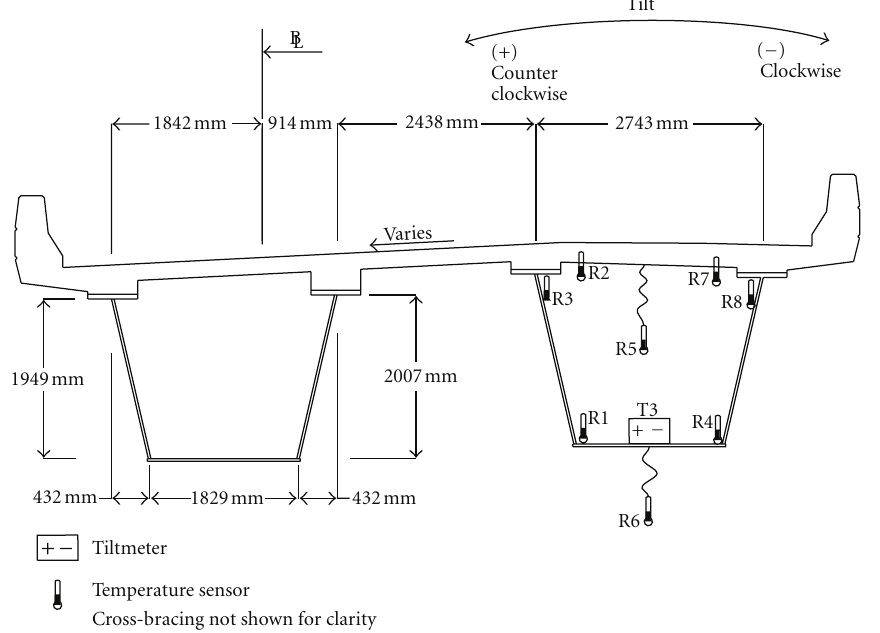
Figure 4: Cross-section of the Hartford Flyover Bridge with temperature sensor